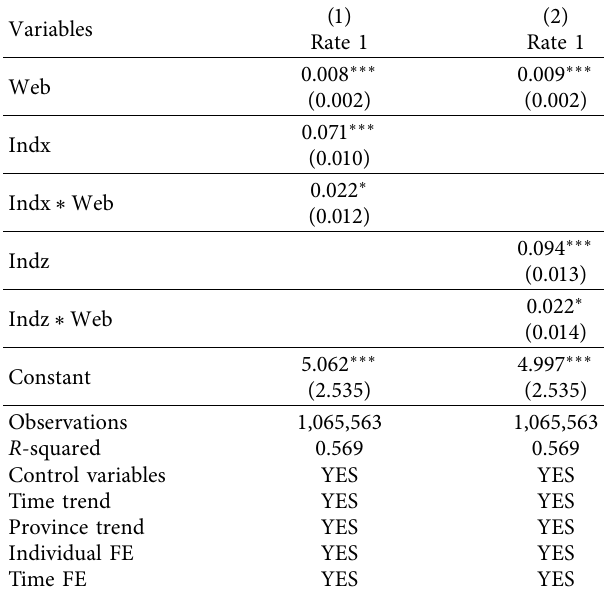
Table 9: Network effect